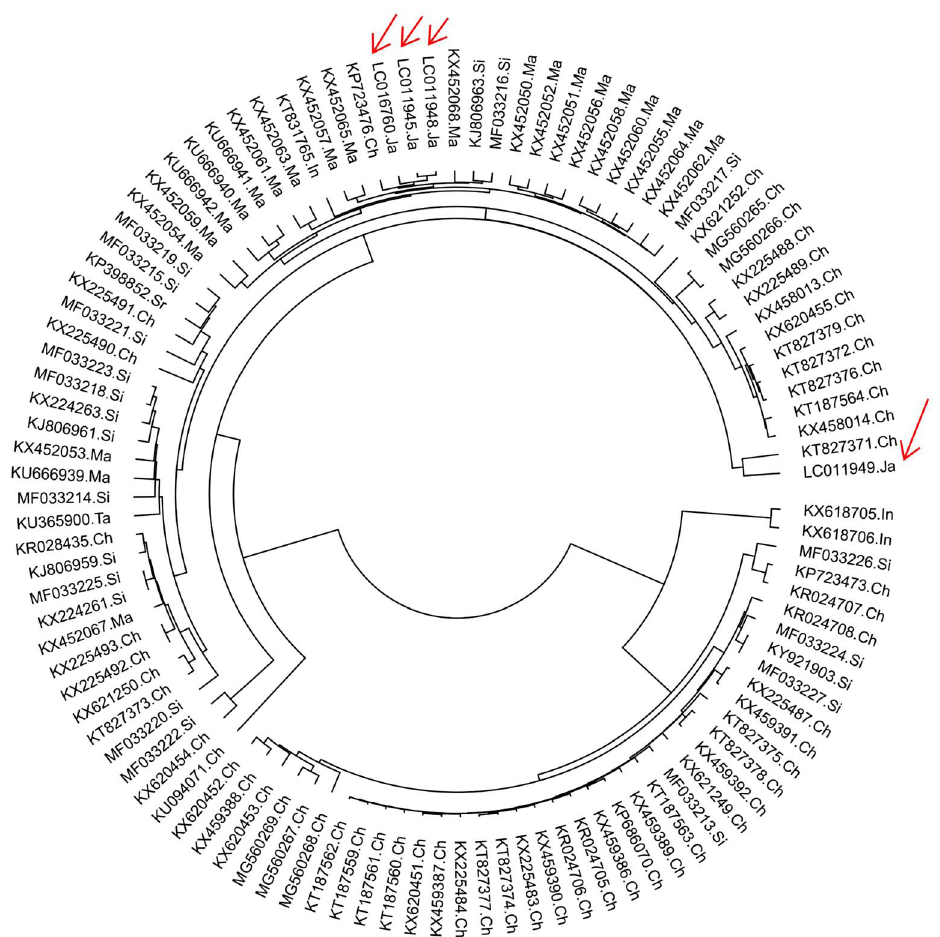
Figure 3. Dendrogram by average criterion for the sequences listed in Table 5 build from the d max values (De fi nition 2.1-ii.). With arrows we indicate the four Japanese sequences from Table